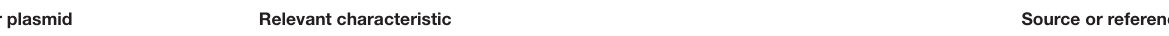
TABLE 1 | Bacterial strains and plasmids used in this study. Strain or plasmid Relevant